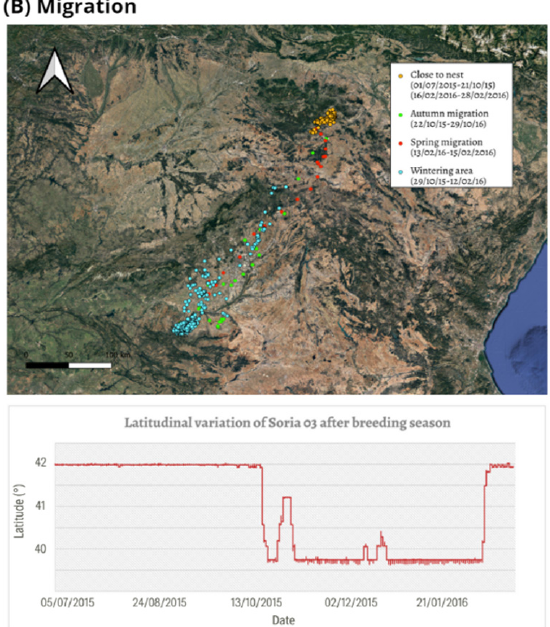
Figure 3. Examples of the different strategies performed by the Spanish red kites: sedentarism ( A ), migration ( B ), and sedentarism with post-reproductive periods ( C ). Each map represents the move- ments of one individual during a single post-breeding period. The latitudinal variation of each individual (Avila01, Soria03, and Palencia01, respectively) is represented below the map.